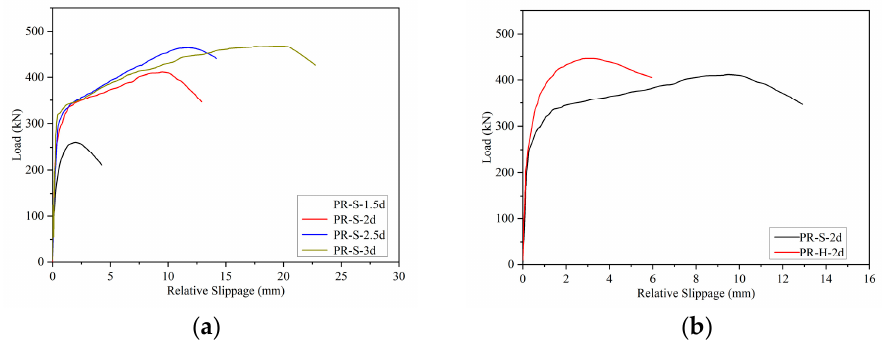
Figure 9. Load-relative slip curve with( a ) different aspect ratios of planted rebars; ( b ) different shapes of planted rebars.